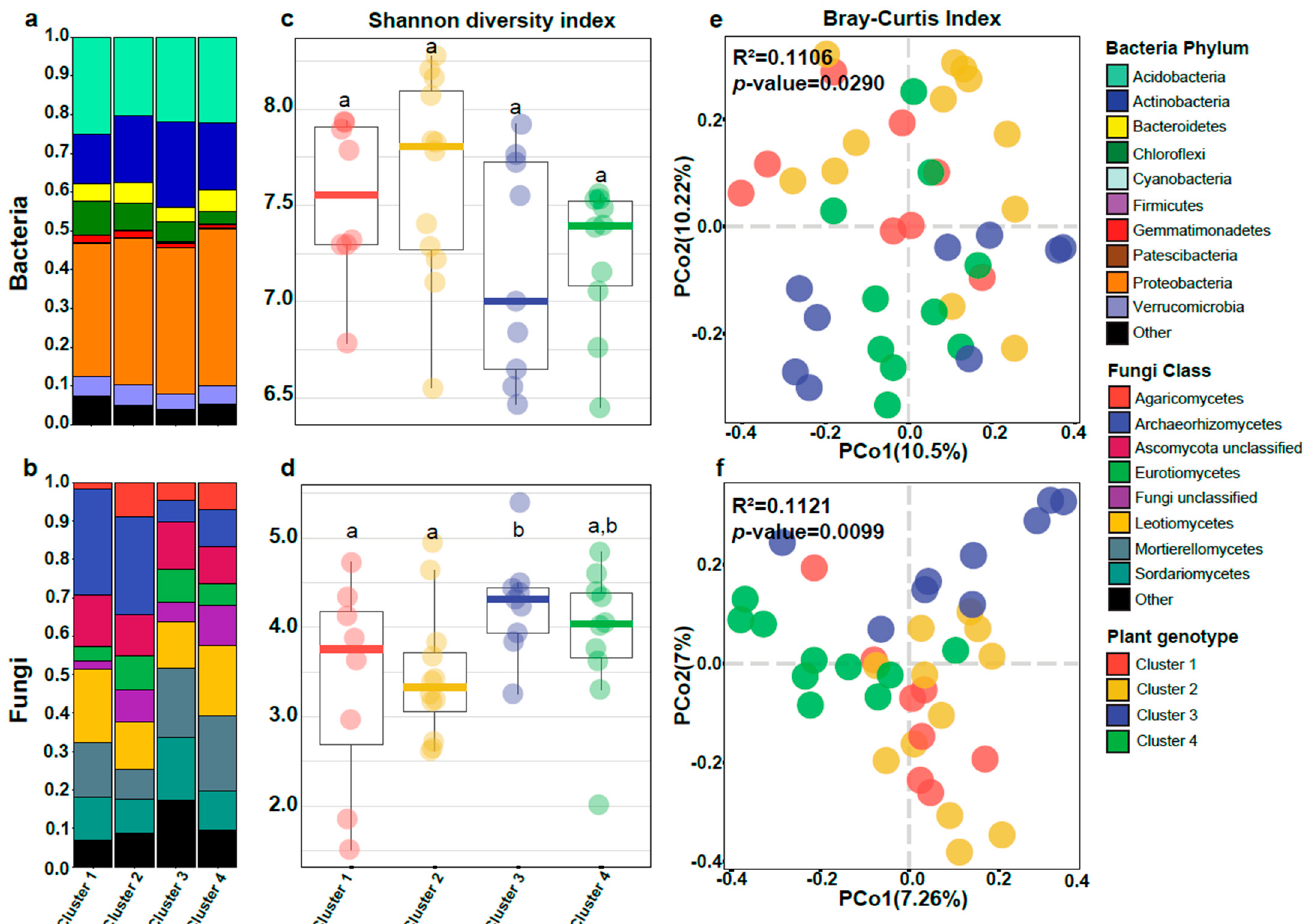
Figure 3. Plant genotype effect over bacterial and fungal communities from the Andean Blueberry rhizosphere. Microbiome composition for bacteria ( a ) and fungi ( b ). Boxplot of the entropy (Shannon Diversity Index) for bacteria ( c ) and fungi ( d ). Letters represent the results of the Tukey HSD post hoc test for one-way ANOVA. Principal Coordinate Analysis based on Bray–Curtis dissimilar- ities between bacterial ( e ) and fungal ( f ) communities across plant genotype clusters. The variance explained ( R 2 ) and the significance ( p -value) are shown for a PERMANOVA model.